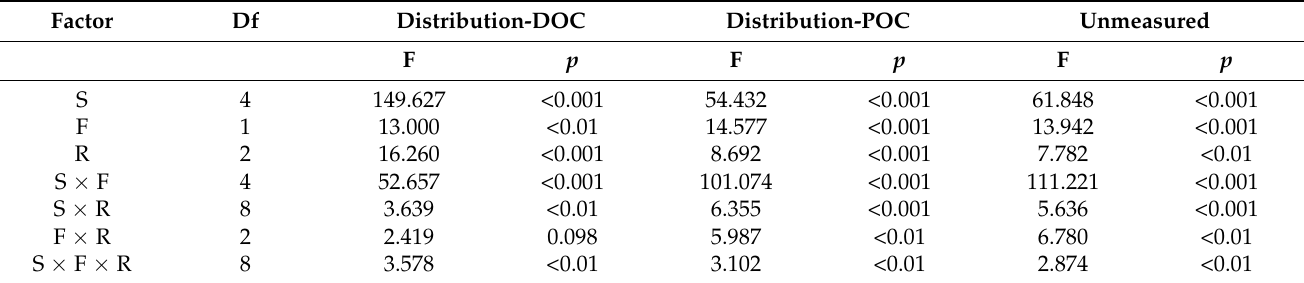
Table 2. ANOVA analysis for the effect of sampling time (S), fertility (F) and residue type